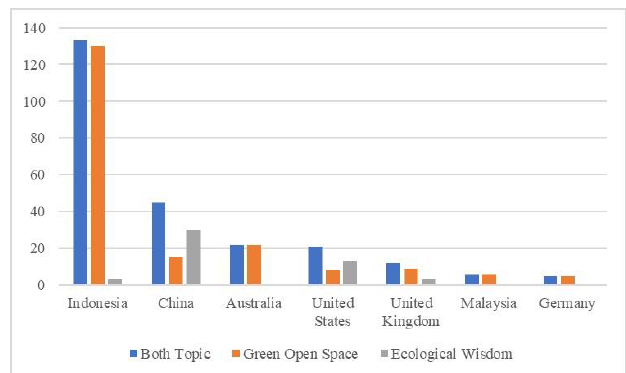
Fig.3. The number of documents by country according to Scopus data